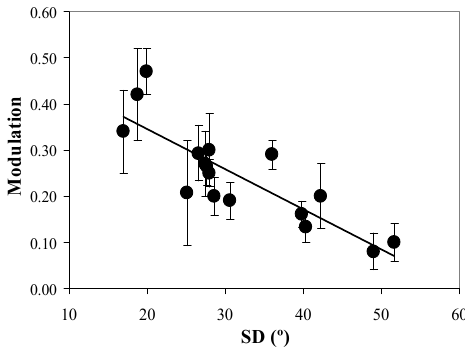
Figure 11. Polarimetric modulation vs. SD for all images involved in the present experiment. Each symbol is the average values across the entire map. Bars represent the standard deviation.